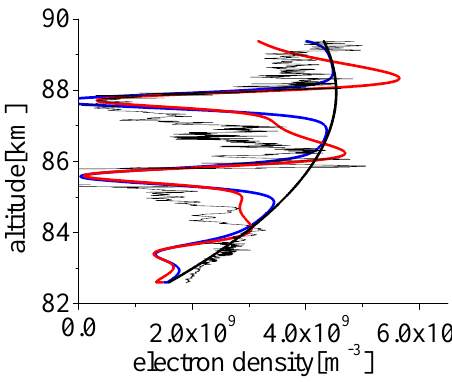
Fig. 4. The ECT02 rocket sounding data (thin black line). The Fig. 5. Electron density profile from the ECT02 rocket data (black Fig.4 The ECT02 rocket sounding data (thin black line). The model calculations results (in a red line). model calculations results (in a red line). With the estimated vertical Fig.5 Electron density profile from the ECT02 rocket data (black thin line). The undisturbed distribution (black thin line). The undisturbed distribution (black thick line) is extrap- wavelength of 2.5km, the period is 4h. With the estimated vertical wavelength of 2.5 km, the period is 4 hours. olated from the ECT02 measuring. The model result which only thick line) is extrapolated from the ECT02 measuring. The model result which only considers the scavenging considers the scavenging electron by ice particle (blue solid line). electron by ice particle (blue solid line). And the charged ice particle distribution together with the ion density And the charged ice particle distribution together with the ion den- distribution effects on the electron density distribution (red solid line). sity distribution effects on the electron density distribution (red solid